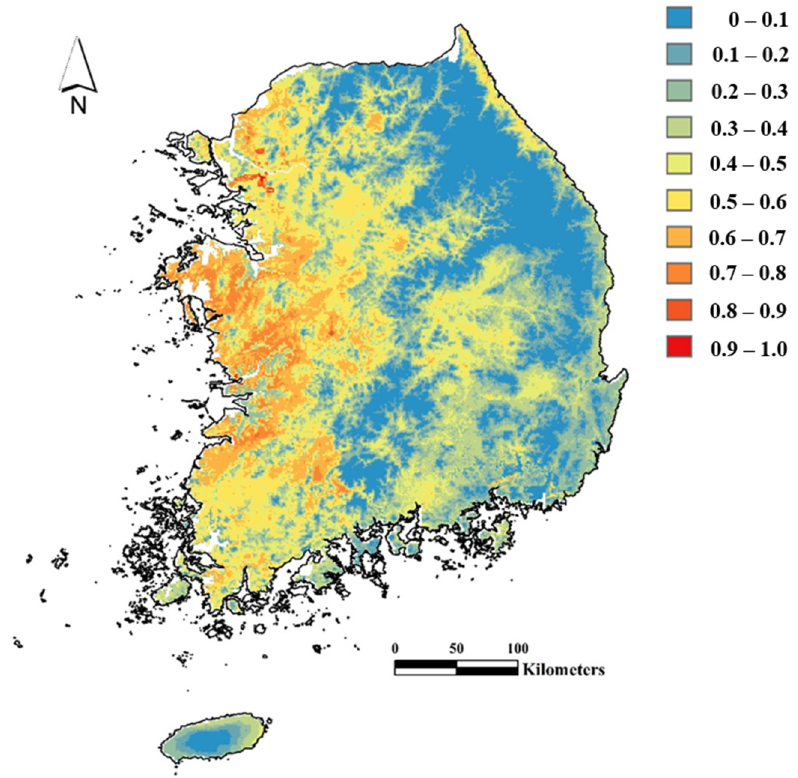
Figure 3. Presence probability maps of R. shantungensis in Korea using the Maximum Entropy Model (MaxEnt).